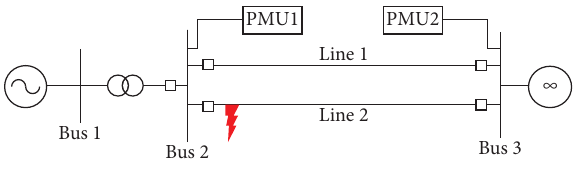
Figure 7: SMIB with fault on line 2. Table 1: SMIB parameters.